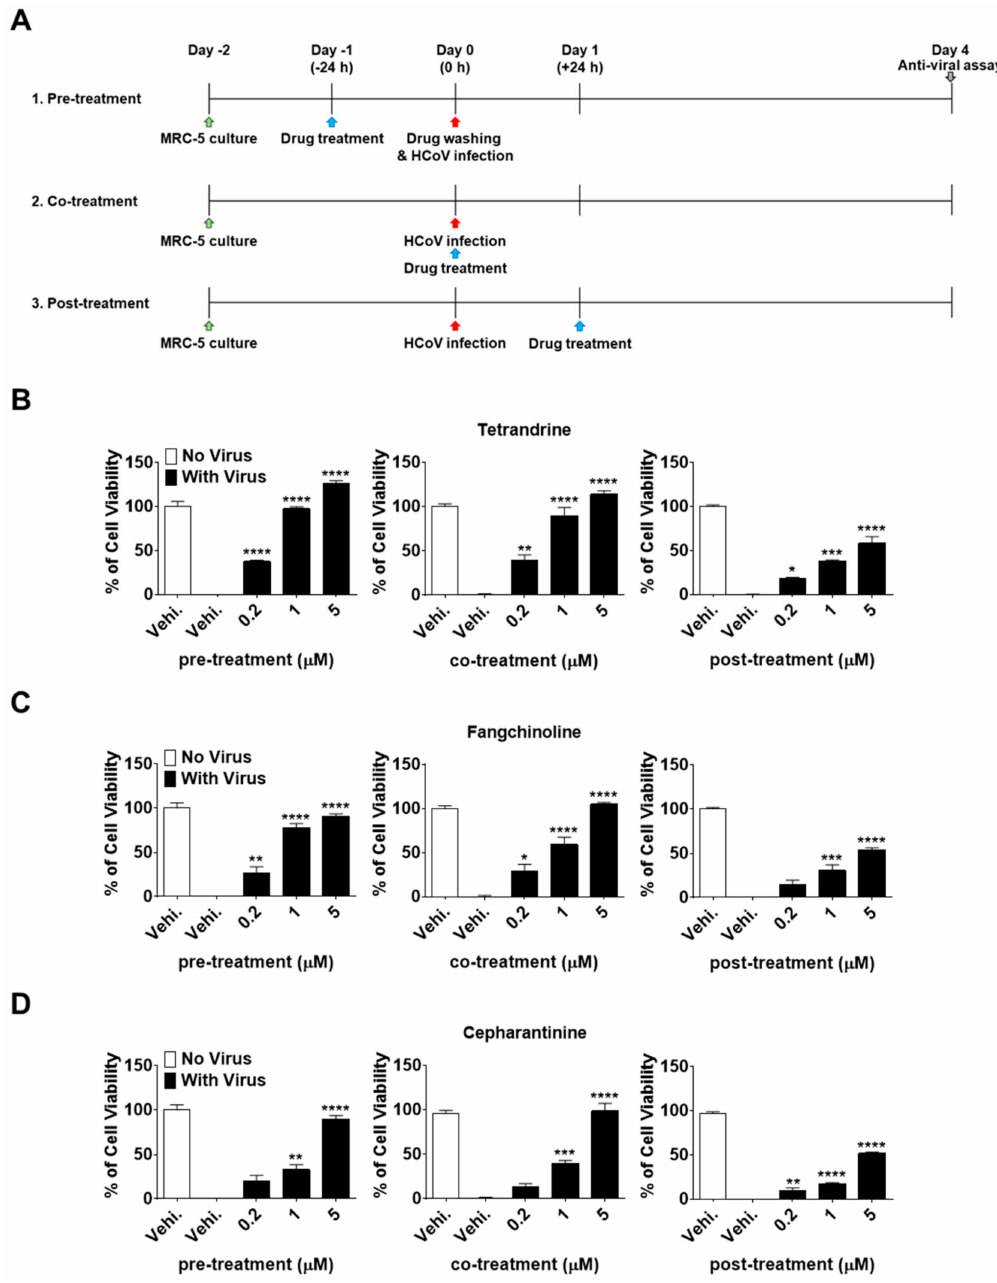
Figure 3. Dose- and time-dependent antiviral activities of TET, FAN, and CEP. MRC-5 cells were infected with HCoV-OC43 with or without the addition of TET, FAN, and CEP at the indicated concentrations (Vehicle 0.025% dimethyl sulfoxide (DMSO)). The compounds were added at 24 h before, during, or 24 h after HCoV-OC43 infection of MRC-5 cells. ( A ) Times of compound addition to infected MRC-5 cells. ( B – D ) Cell viability of pre-, co-, post- compound treated cells was assessed using the MTS assay at four dpi. Data are presented as mean ± SEM of three independent experiments. * p < 0.05, ** p < 0.01, *** p < 0.001, and **** p < 0.0001 versus the vehicle-treated virus-infected group (one-way ANOVA plus Tukey’s multiple comparisons